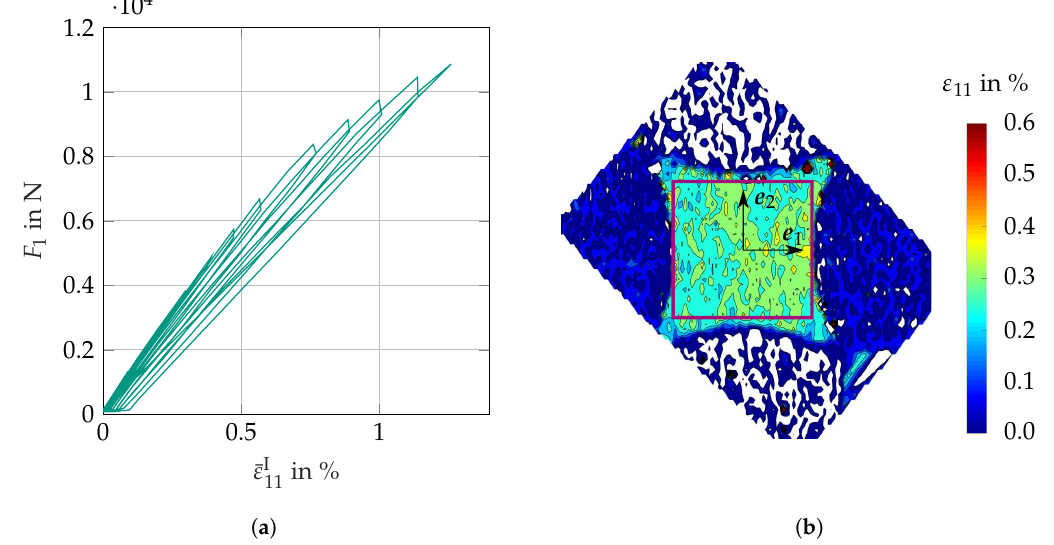
Figure 16. Geometry 2 with continuous fiber reinforced arms with loading scenario P Γ = 0 . ( a ) Force F 1 in e 1 -direction over averaged normal strain ¯ ε I in the area of interest; ( b ) Contour plot of the normal 11 = 0.3%. strain ε 11 at ¯ ε I 11